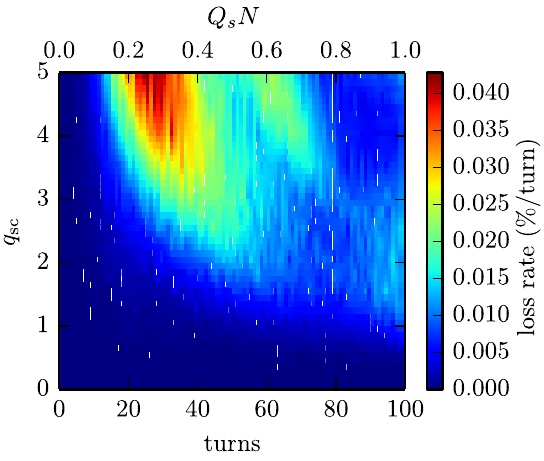
FIG. 10. Loss rate for different space charge from the simu- lation scan shown in Fig. 9. The aperture radius is 3 . 5 σ 0 þ A 0 .